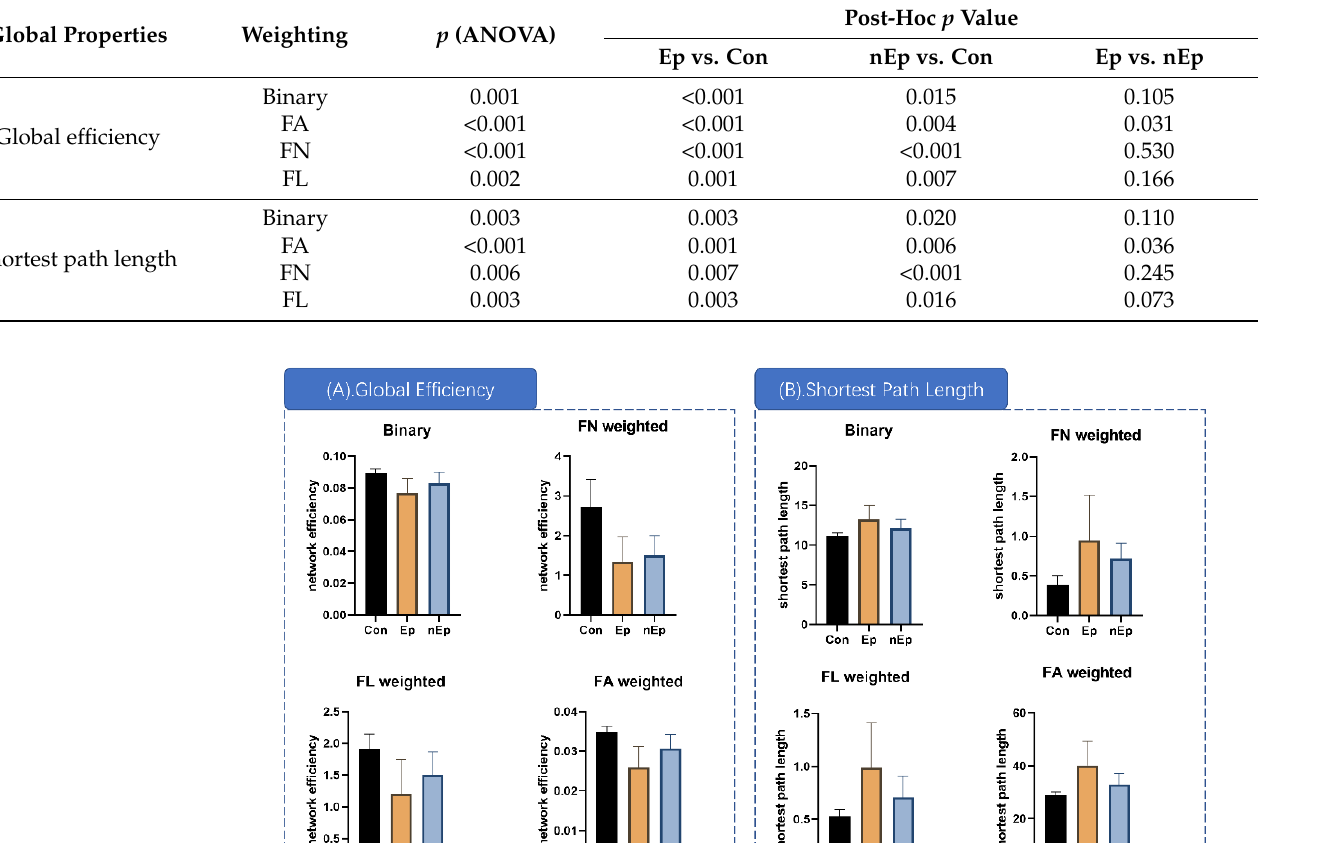
Table 3. Global properties with significant inter-group differences.